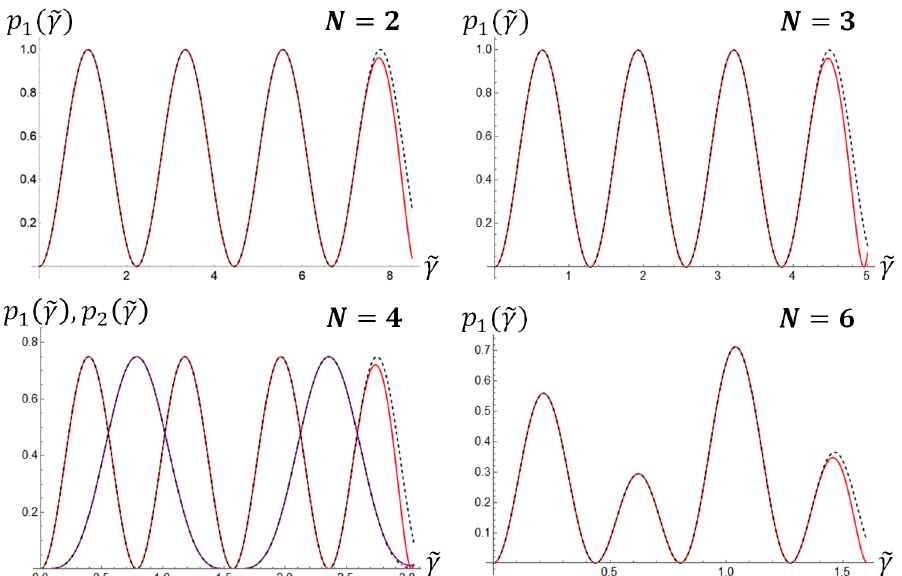
Figure 1. Evolution of the probability of generating one SH photon from N pump photons. Solid red line: Tr [ ˆ ρ ( ˜ γ ) 1 F ⊗ ˆ n k ] where ˆ ρ is obtained by expanding ˆ U in Equation (29) up to k = 30. Dashed line: theoretical prediction from Equation (39). The purple solid line in the bottom left panel is the probability of generating two photons from four. It is of the form A sin 4 ( ω ˜ γ )